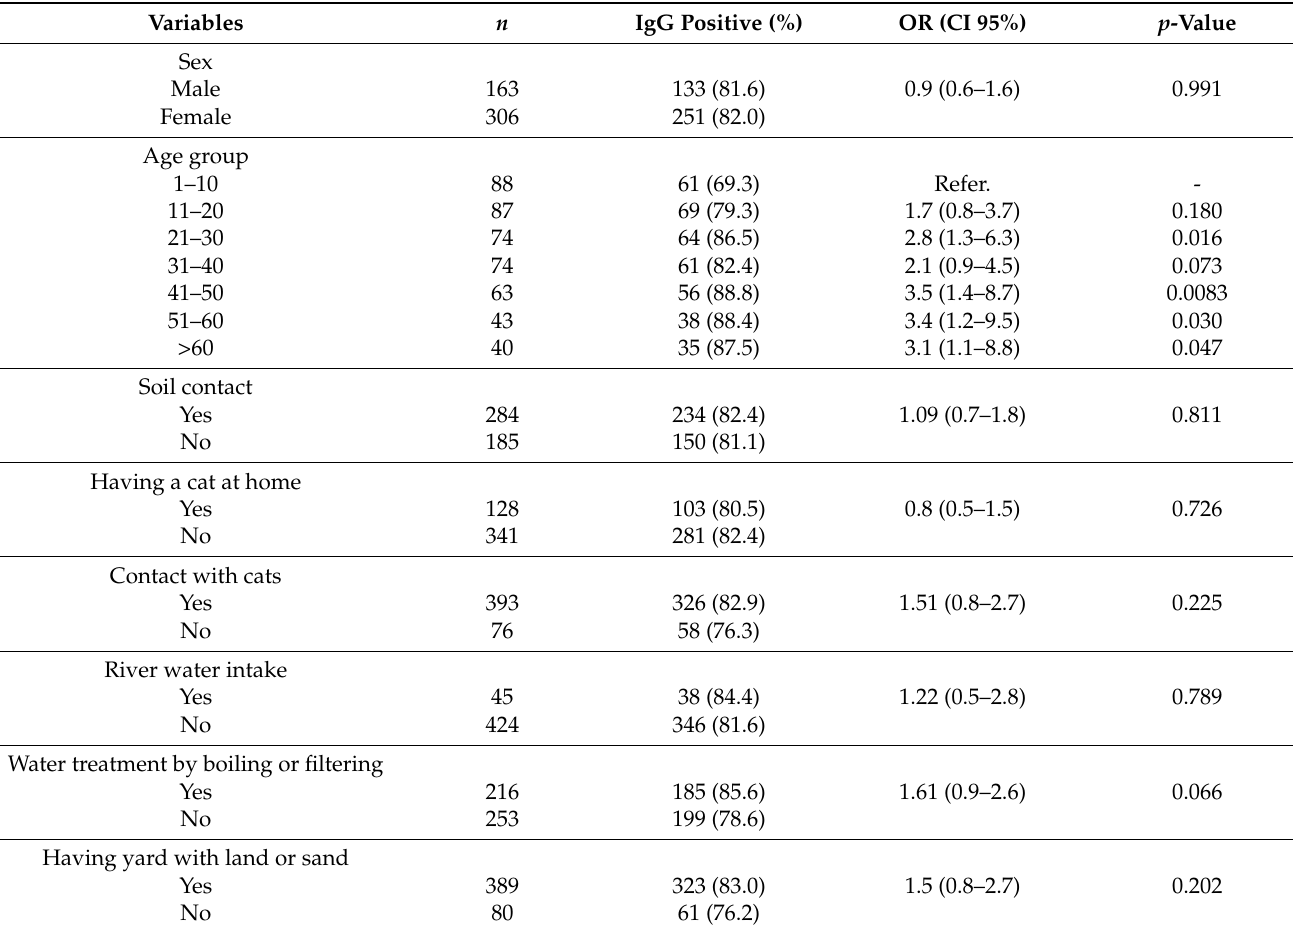
Table 4. Bivariate analysis between the studied variables and anti- T. gondii IgG seropositivity in individuals living in the urban area of the municipality of Ponta de Pedras, Par á , Brazil, from August 2015 to April 2018.